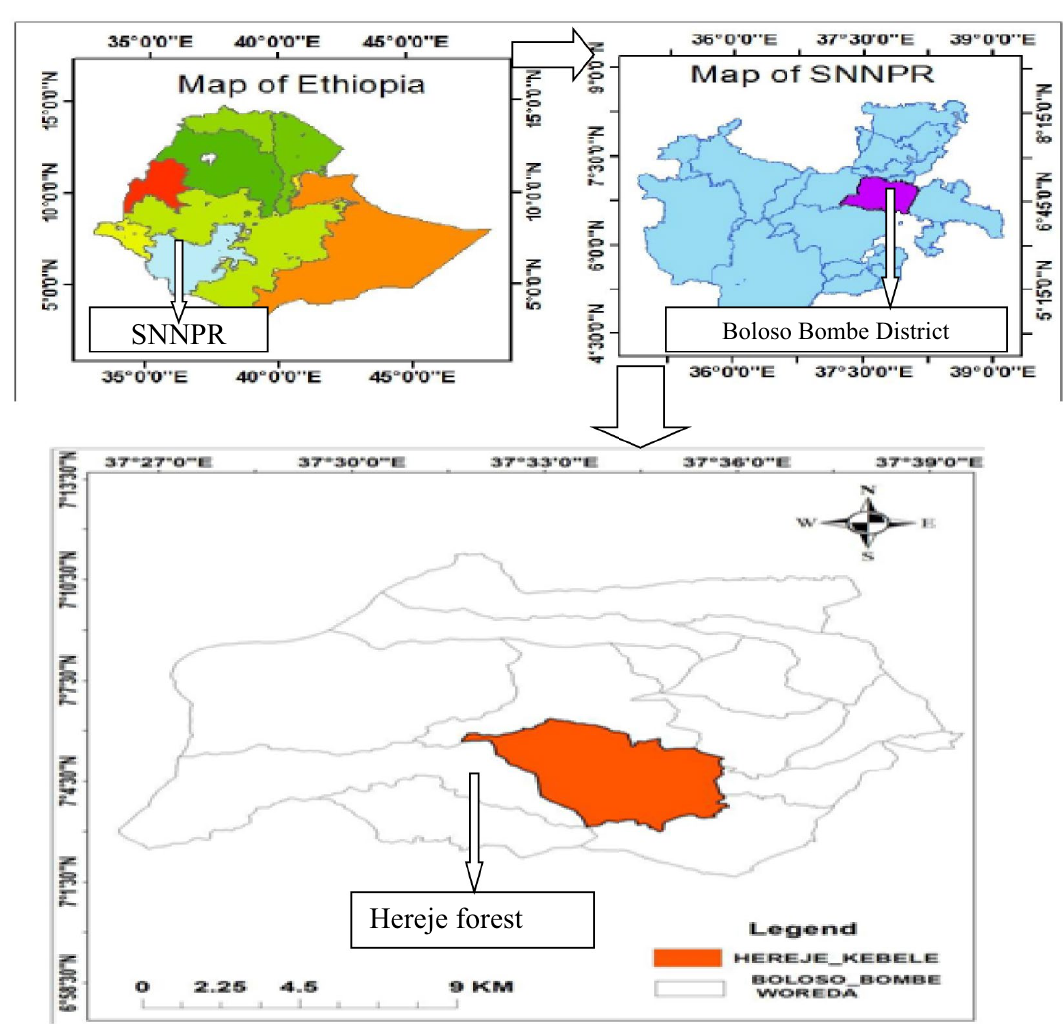
Fig. 1 Map of the Boloso Bombe district and Hereje forest, Southern